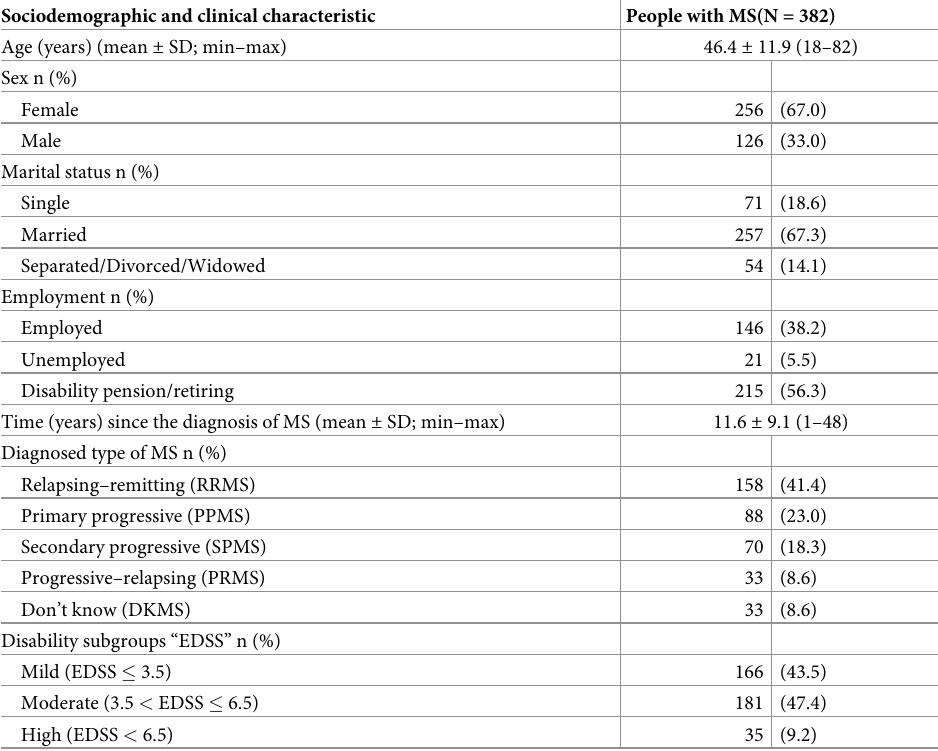
Table 1. Sociodemographic and clinical characteristic of the